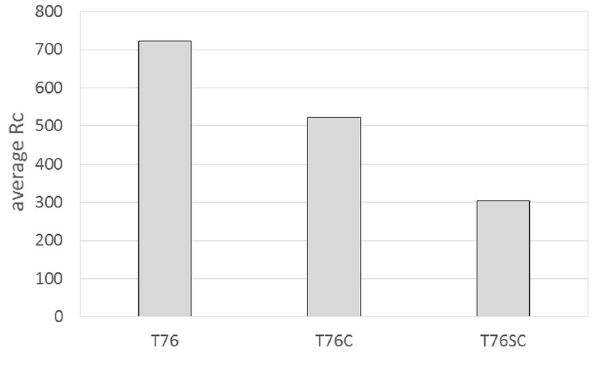
Fig. 10 Comparison among the modified roundness values in T7451 and T7451C tempers as a function of the